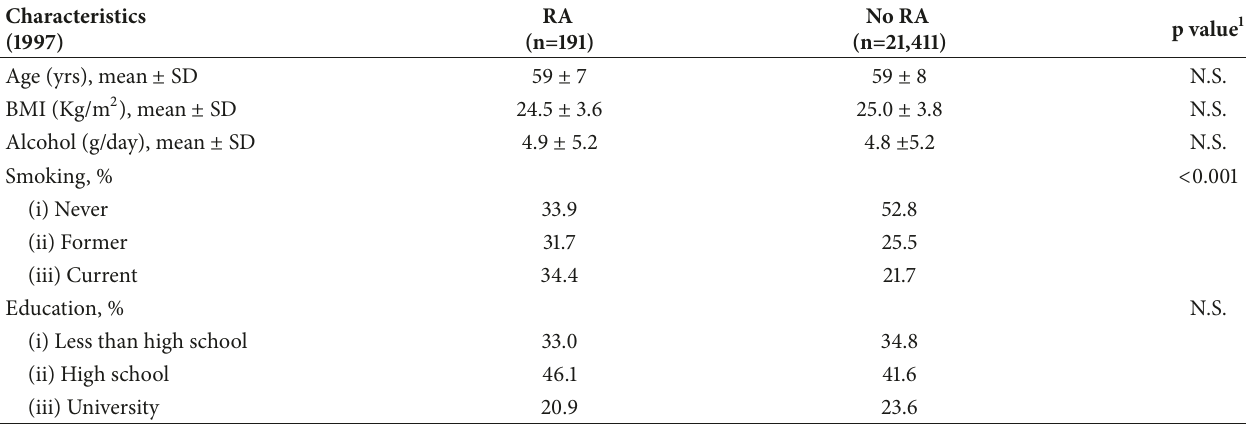
Table 1: Baseline characteristics of participants of the Swedish Mammography Cohort with or without RA diagnosis between 1997 and 2009. Characteristics